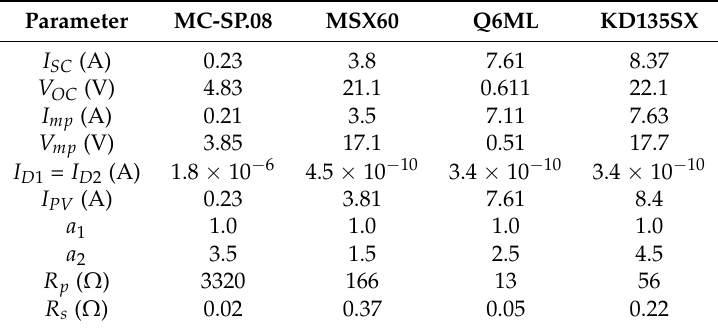
Table 1. Parameters of the simulation